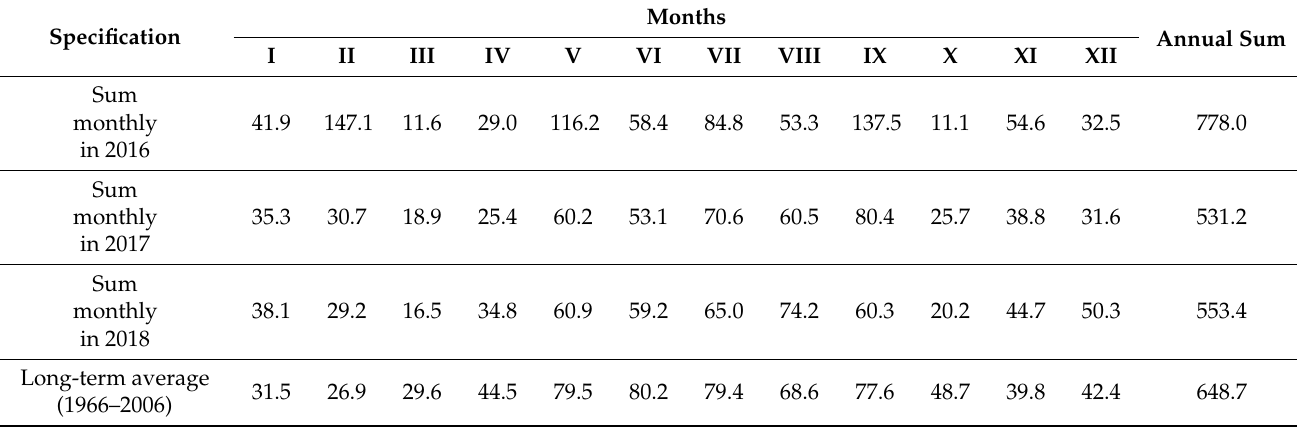
Table 3. The sum and distribution of precipitation (mm) in 2016–2018.